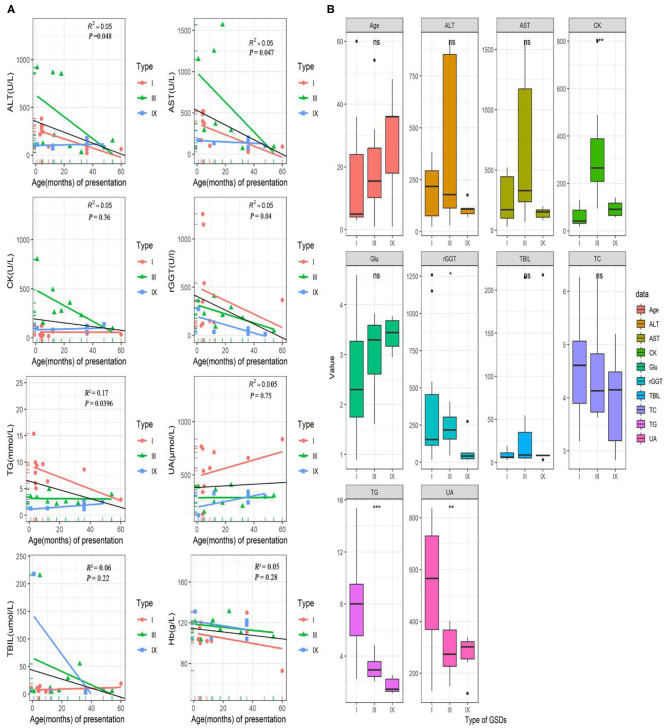
Laboratory test and data for GSD patients. (A) Correlation of AST, ALT, rGGT, TG, CK, UA, TBIL, and Hb levels with age (months) at onset in pediatric patients with GSDs. The colorful lines represent fitting curve for GSD I(red), III(green), and IX(blue). The black line is the regression line for all GSD patients. (B) Differences in several laboratory inspection items between 11 GSD I, eight GSD III, and seven GSD IX. Statistical method is one-way analysis of variance. ⋆P < 0.05; ⋆⋆P < 0.01; ⋆⋆⋆P < 0.001. ALT, alanine aminotransferase; AST, aspartate aminotransferases; CK, creatine kinase; GGT, gamma-glutamyl transferase; TG, triglyceride; UA, uric acid; TBIL, total bilirubin; Hb, hemoglobin; TC, cholesterol; Glu, blood glucose.